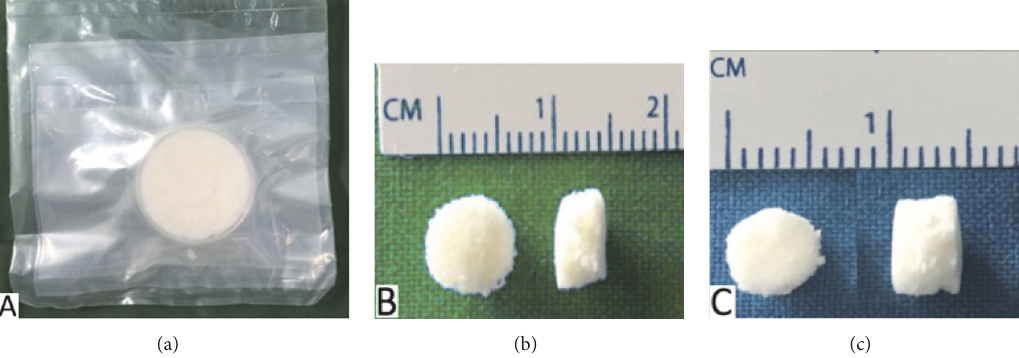
Figure 1: (a) Sponge bovine cartilage scaffold 5cm in diameter, (b) sponge bovine cartilage scaffold in SBCS group, 5mm in diameter, and (c) sponge scaffold in DSBCS group, 5 mm in